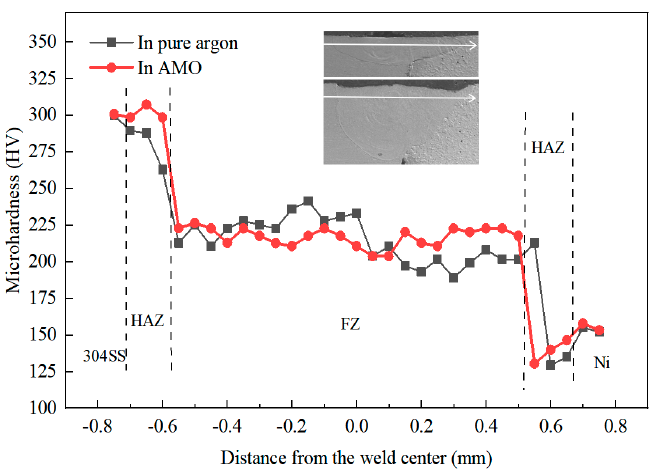
Figure 15. Microhardness distribution in the horizontal direction for welding joints in pure argon and the AMO.